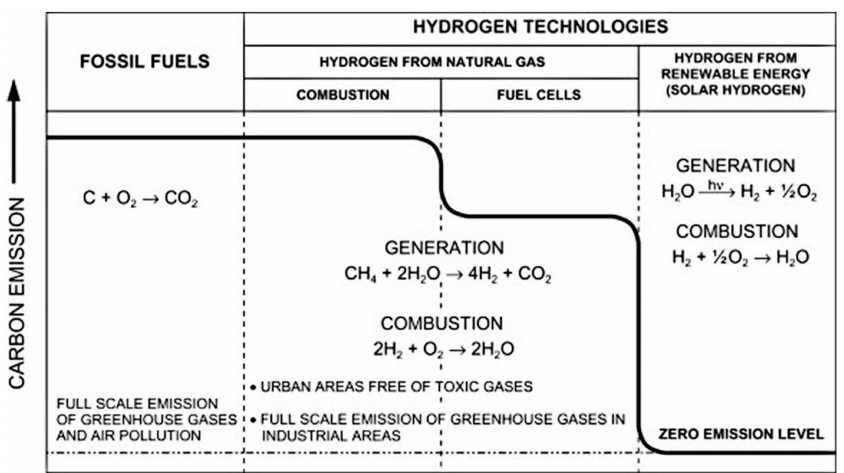
Figure 12. Impact of hydrogen production and combustion on emission of carbon [117]. Reproduced with permission from Elsevier,